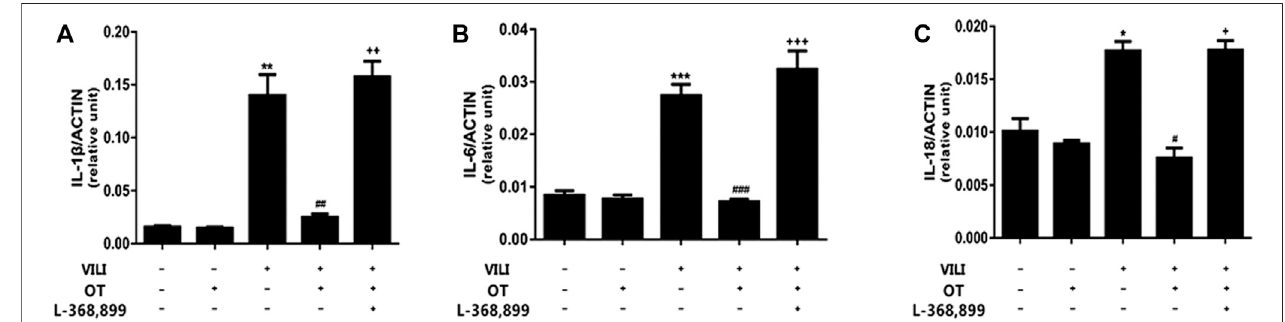
FIGURE 4 | Oxytocin attenuates in fl ammatory cytokine gene expression in the lung tissues of ventilation-induced lung injury.Effects of OT on the expression of the IL-1 β (A) , IL-6 (B) , and IL-18 (C) mRNAs inlung tissues are presented as themeans ± SD ( n (cid:2) 4). * p < 0.05, ** p < 0.01, and *** p < 0.001 compared with the Control and Control+OTgroups; # p < 0.05, ## p < 0.01,and ### p < 0.001comparedwiththeVILIgroup. + p < 0.05,++ p < 0.01,and +++ p < 0.001comparedwiththeOT+VILIgroup. OT, oxytocin; SD, standard deviation; VILI, ventilation-induced lung injury.